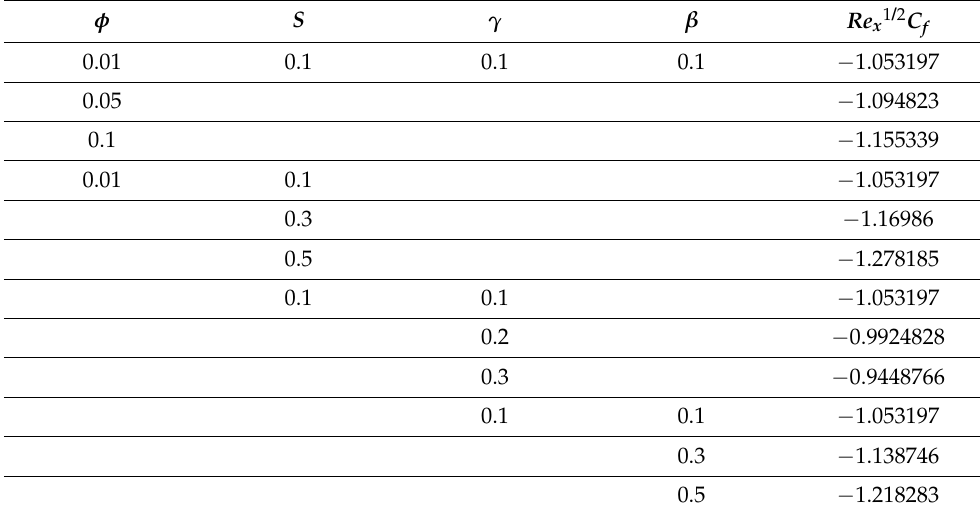
Table 2. Skin friction coefficient variations for various parameters.